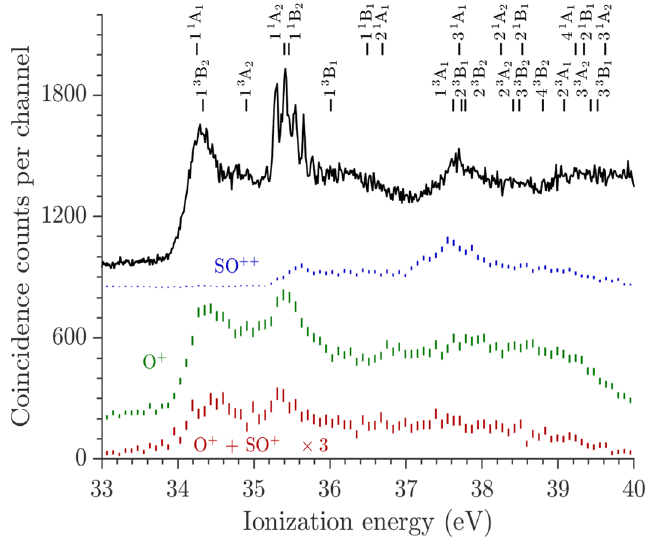
Figure 1. Spectra of electron pairs coincident with O + + SO + ion pairs and with specified single ions, are compared with a well-resolved spectrum of all electron pairs, all after photoionization of SO 2 at the photon energy hν = 40.81 eV. The SO 2+ and O + curves are displaced vertically on a common scale (with constant off-sets) and show true relative intensities, while the other spectra included for comparison have intensity scales adjusted for display. The combs correspond to the MRCI/aug-cc-pV(Q + d)Z computed vertical double ionization energies of SO 2 given in Table S1 and quoted for C 2v